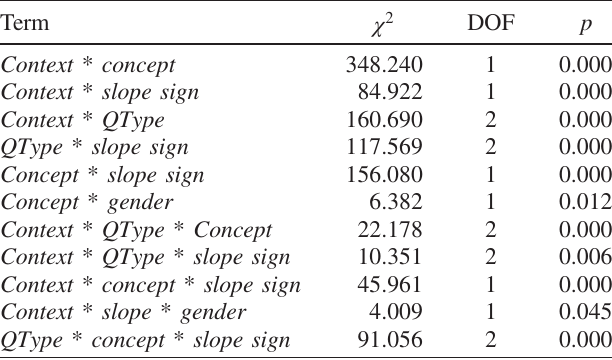
TABLE II. Significant two-way and three-way interaction effects with Wald χ 2 , degrees of freedom (DOF), and significance ( p value) up to three digits.